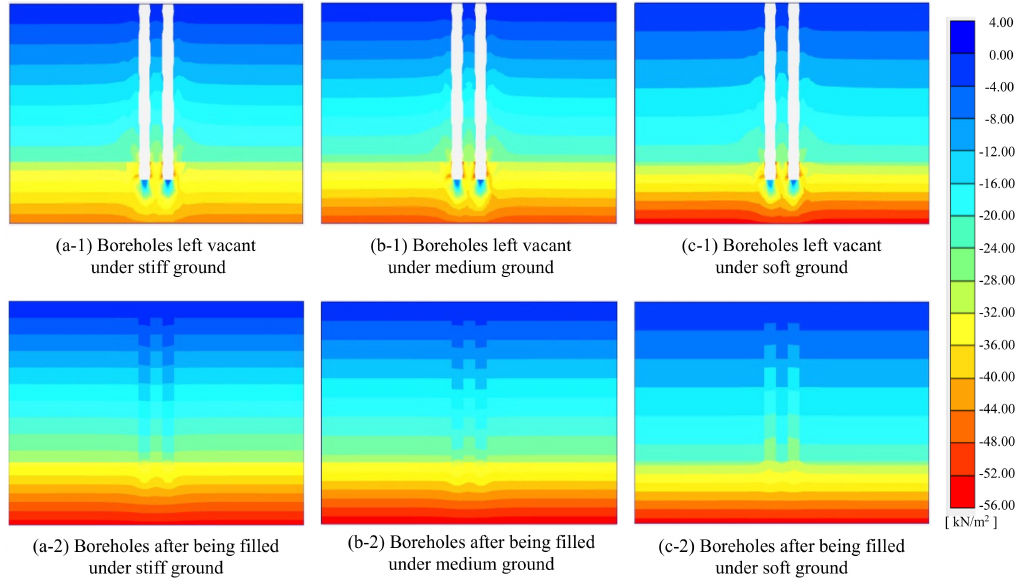
Figure 8. Comparison of frontal cross sectional total stress contour for vacant and filled cases of double